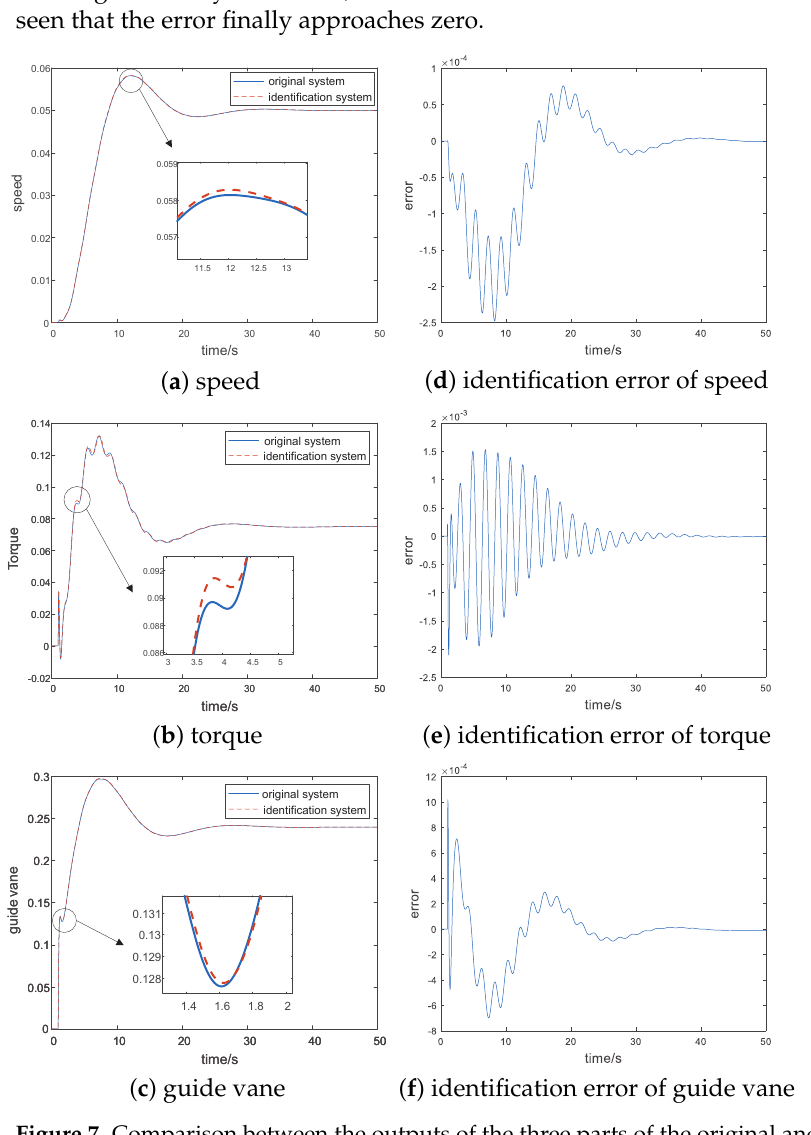
Figure 7. Comparison between the outputs of the three parts of the original and the identification systems under 5% frequency